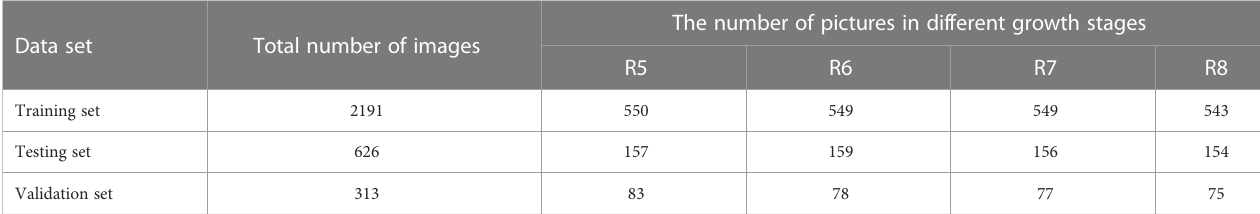
TABLE 1 Distribution of soybean plants in each data set in different growth stages.